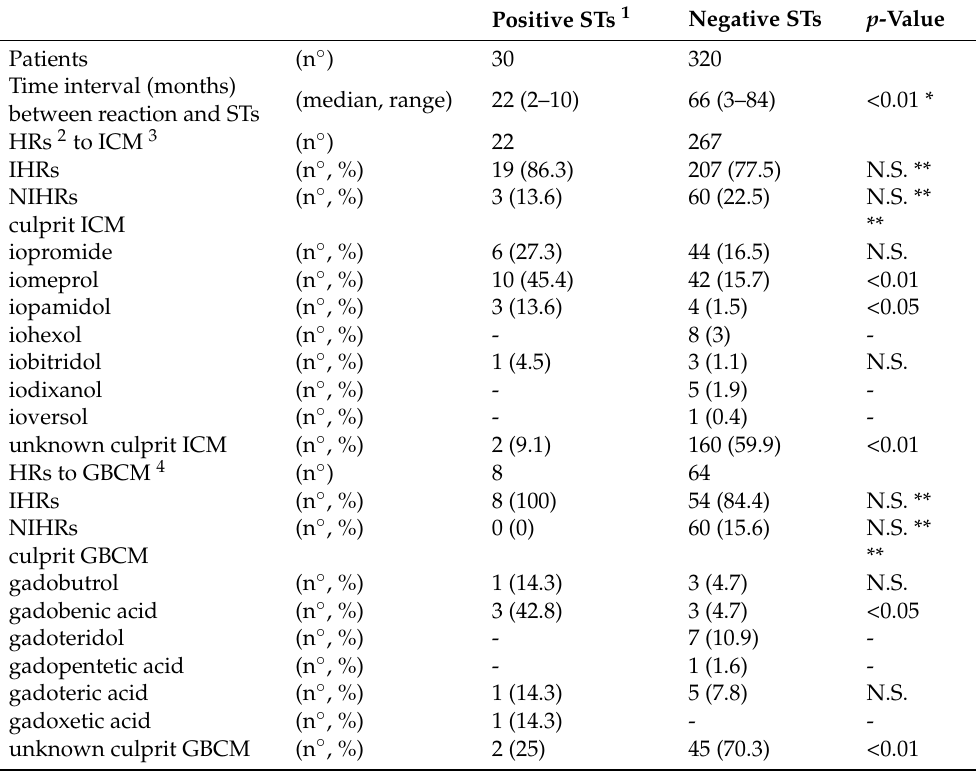
Table 4. Comparison between patients with HRs to ICM and patients with HRs to GBCM.